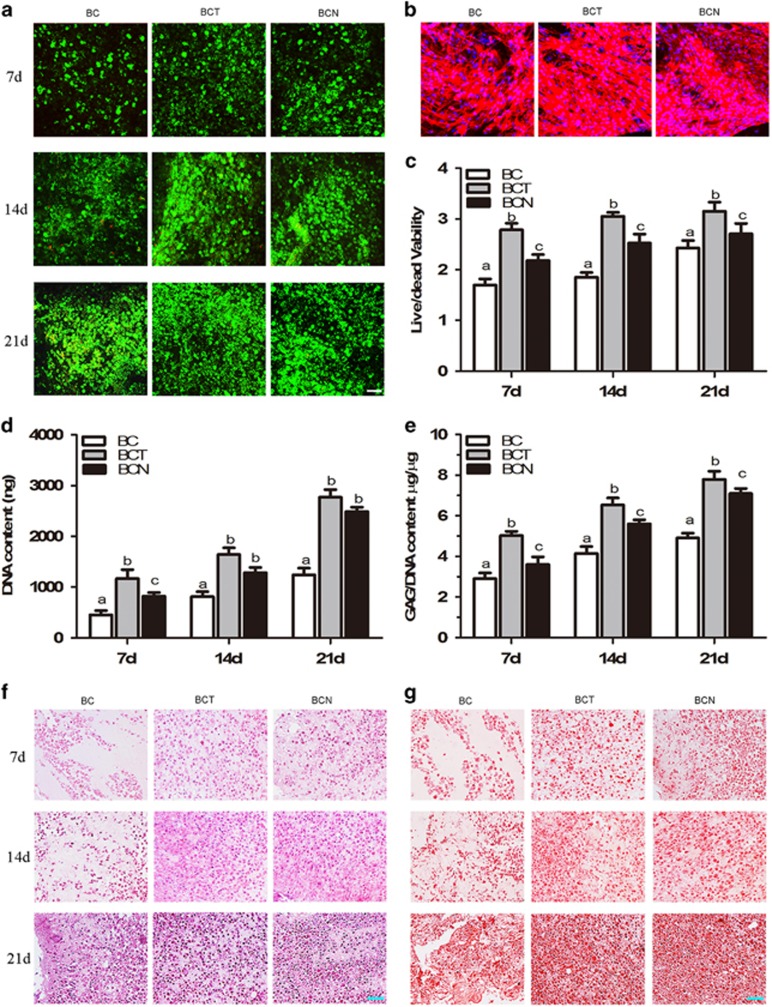
Effects of NGF on BMSCs grown in 3D cultures. (a) Cell viability of the cultured 3D constructs on days 7, 14 and 21. (b) Phalloidin/Hoechst 33258 stained actin filaments of the constructs on day 21. (c) Cell viability was calculated after culture for 7, 14 and 21 days. DNA (d) and GAG (e) contents of the constructs cultured with different media for 7, 14 and 21 days. (f and g) HE and Safranin O staining were performed on sections of the cultured constructs on days 7, 14 and 21. The values are means±S.D., n=6; bars with different letters are significantly different from each other at P<0.05, Scale bar=100 μm